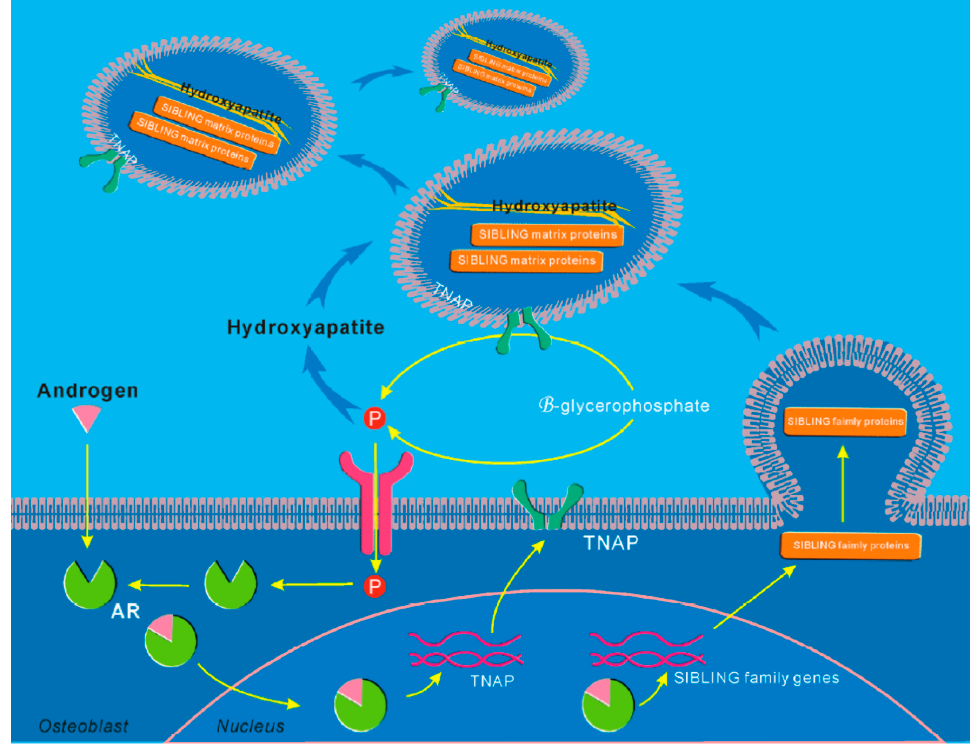
Figure 1. Molecular schemas of androgen/AR actions on osteoblastic mineralization. Androgen/AR induces TNAP and SIBLING family gene expression in osteoblasts by binding to the ARE motif in these gene promoter regions. The androgen-enhanced TNAP expression and activity results in an increased Pi concentration from the hydrolysis of β -glycerophosphate. The transport of Pi into the cell results in a further stimulation AR expression and mineralization in osteoblasts. The regulation of TNAP and SIBLING gene expression by androgen and AR ensures that su ffi cient TNAP activity is available at the outer membrane surface of osteoblasts and matrix vesicles to provide su ffi cient Pi, and SIBLING matrix proteins required for the initial formation of hydroxyapatite crystals during osteoblastic mineralization. ARE: androgen response elements; TNAP: tissue non-specific alkaline phosphatase; SIBLING: the